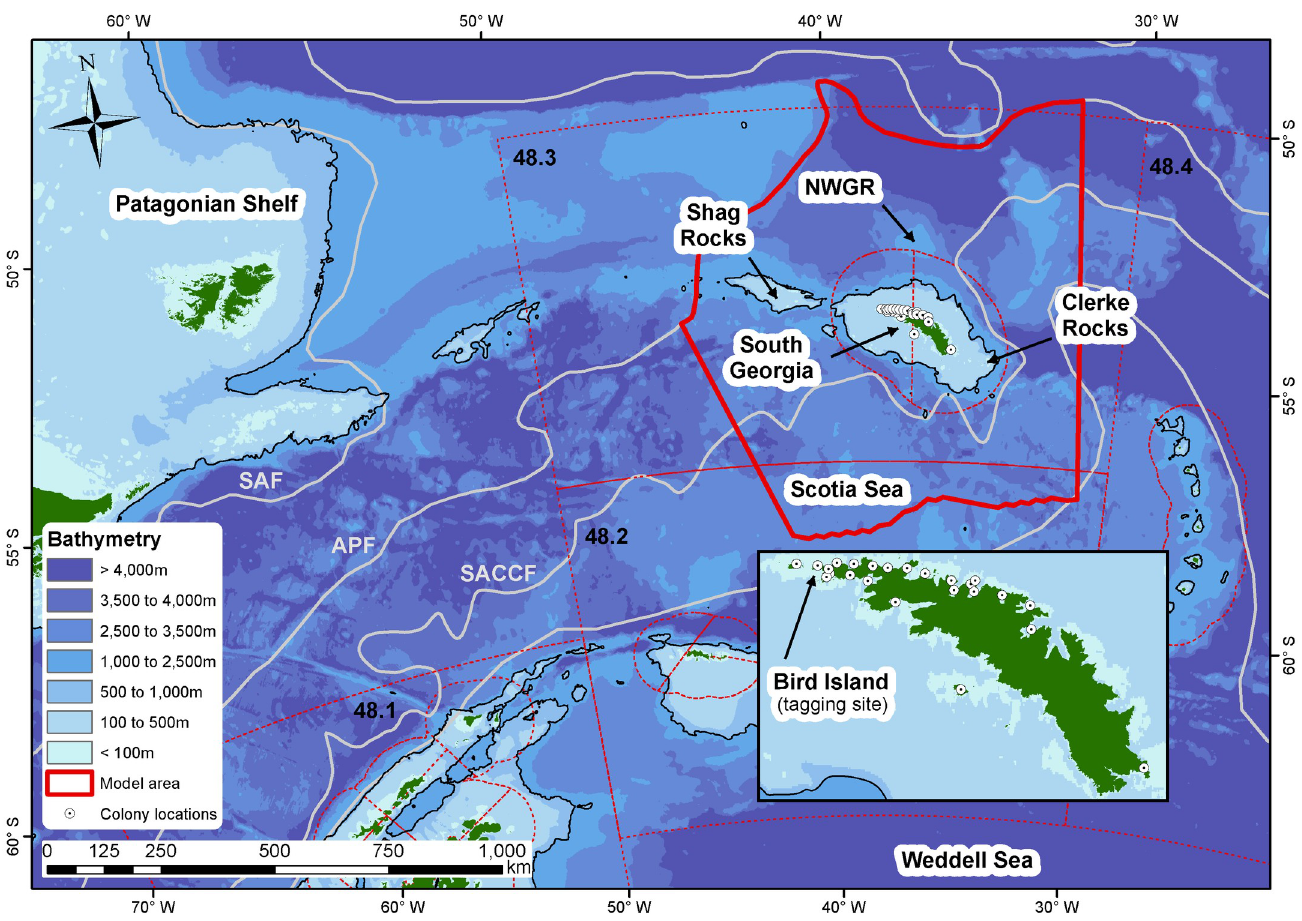
Fig 1. The Scotia Sea region depicting FAO statistical boundaries for CCAMLR Subareas 48.1, 48.2, 48.3, and 48.4. Model area is highlighted in solid red. Major fronts in the Antarctic Circumpolar Current are depicted in grey, and from north to south are: the Sub-Antarctic Front (SAF); the Antarctic Polar Front (APF); the Southern Antarctic Circumpolar Current Front (SACCF); and the Southern Boundary of the Antarctic Circumpolar Current (SBACC). Solid black line denotes the 1000 m isobath, and is indicative of the ‘shelf-break’. Northwest Georgia Rise (NWGR) is indicated. Bird Island (the tagging site) is indicated in the magnified panel. Bathymetry data General Bathymetric Chart of the Oceans (GEBCO).